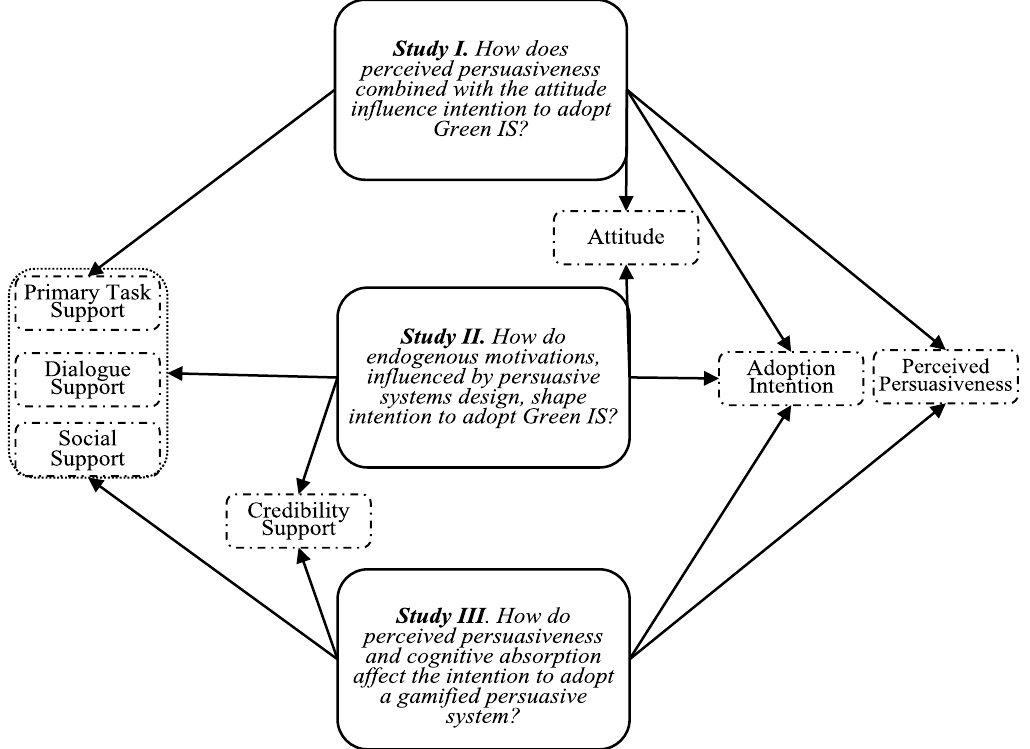
Figure 1. Studies I–III: research questions and common research constructs.